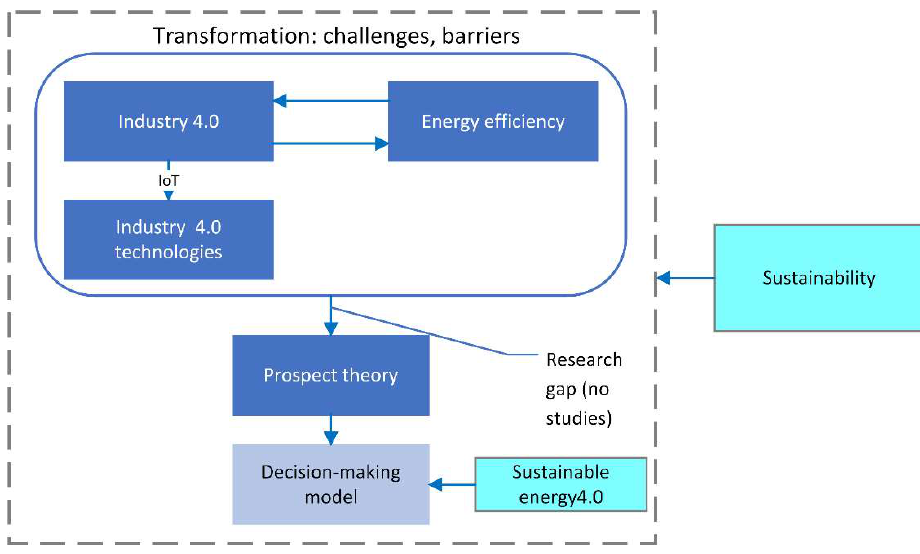
Figure 2. The link between Industry 4.0, Energy efficiency and sustainability–literature research gap.